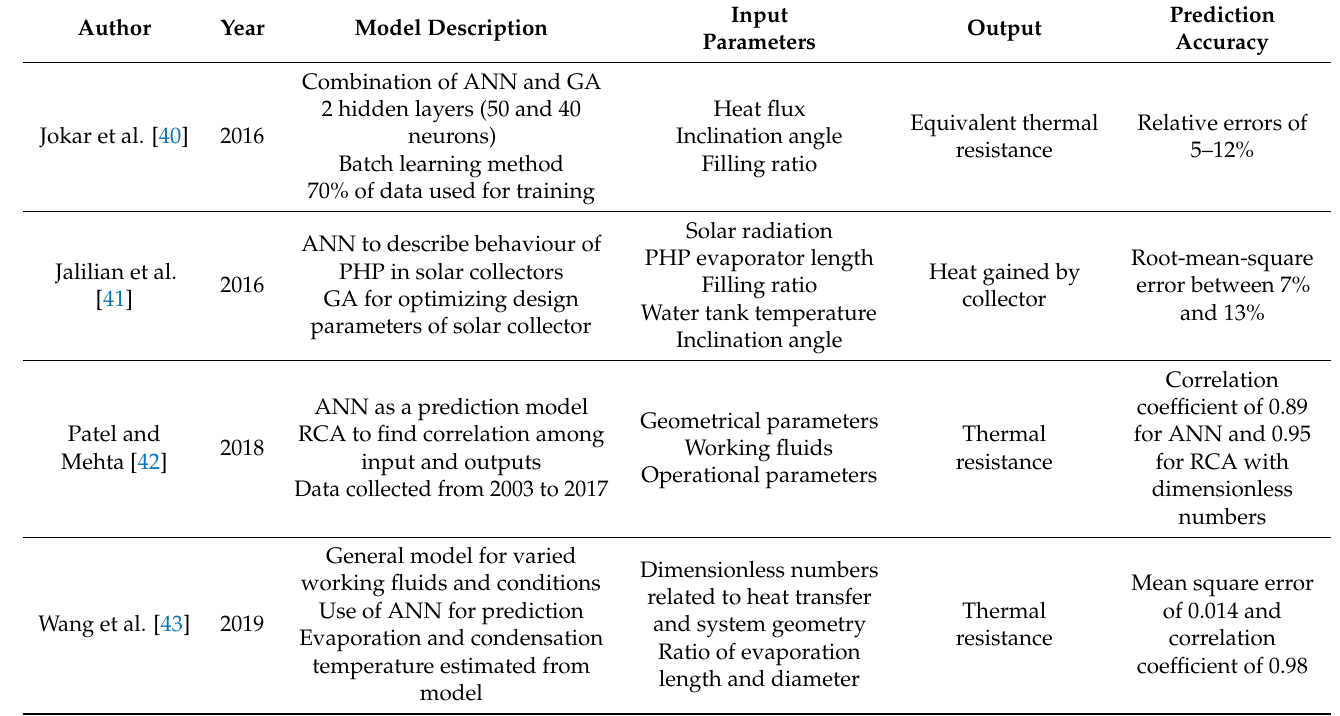
Table 1. Relevant studies on machine learning applied to